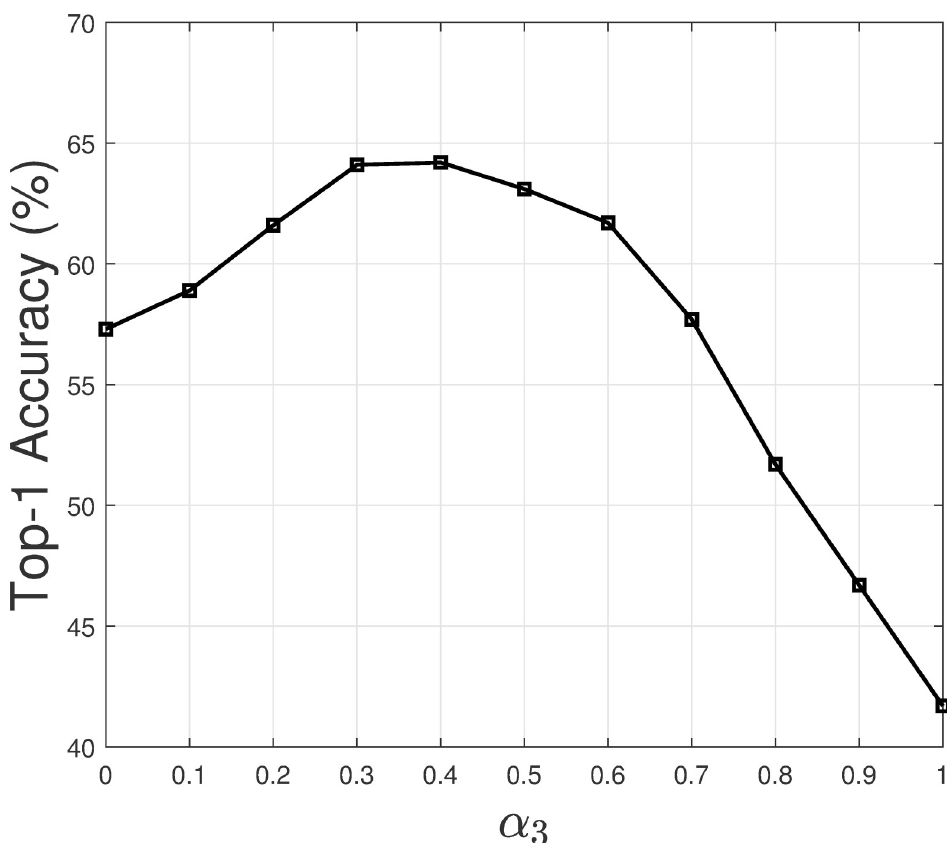
Fig 10. Top-1 accuracy when α 3